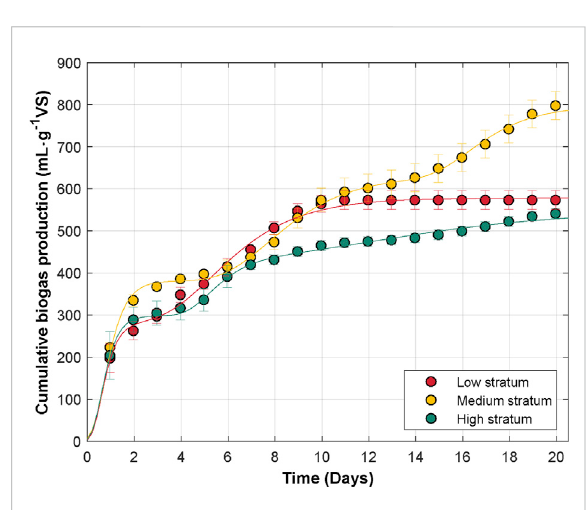
FIGURE 4 Cumulative biogas production curves of the